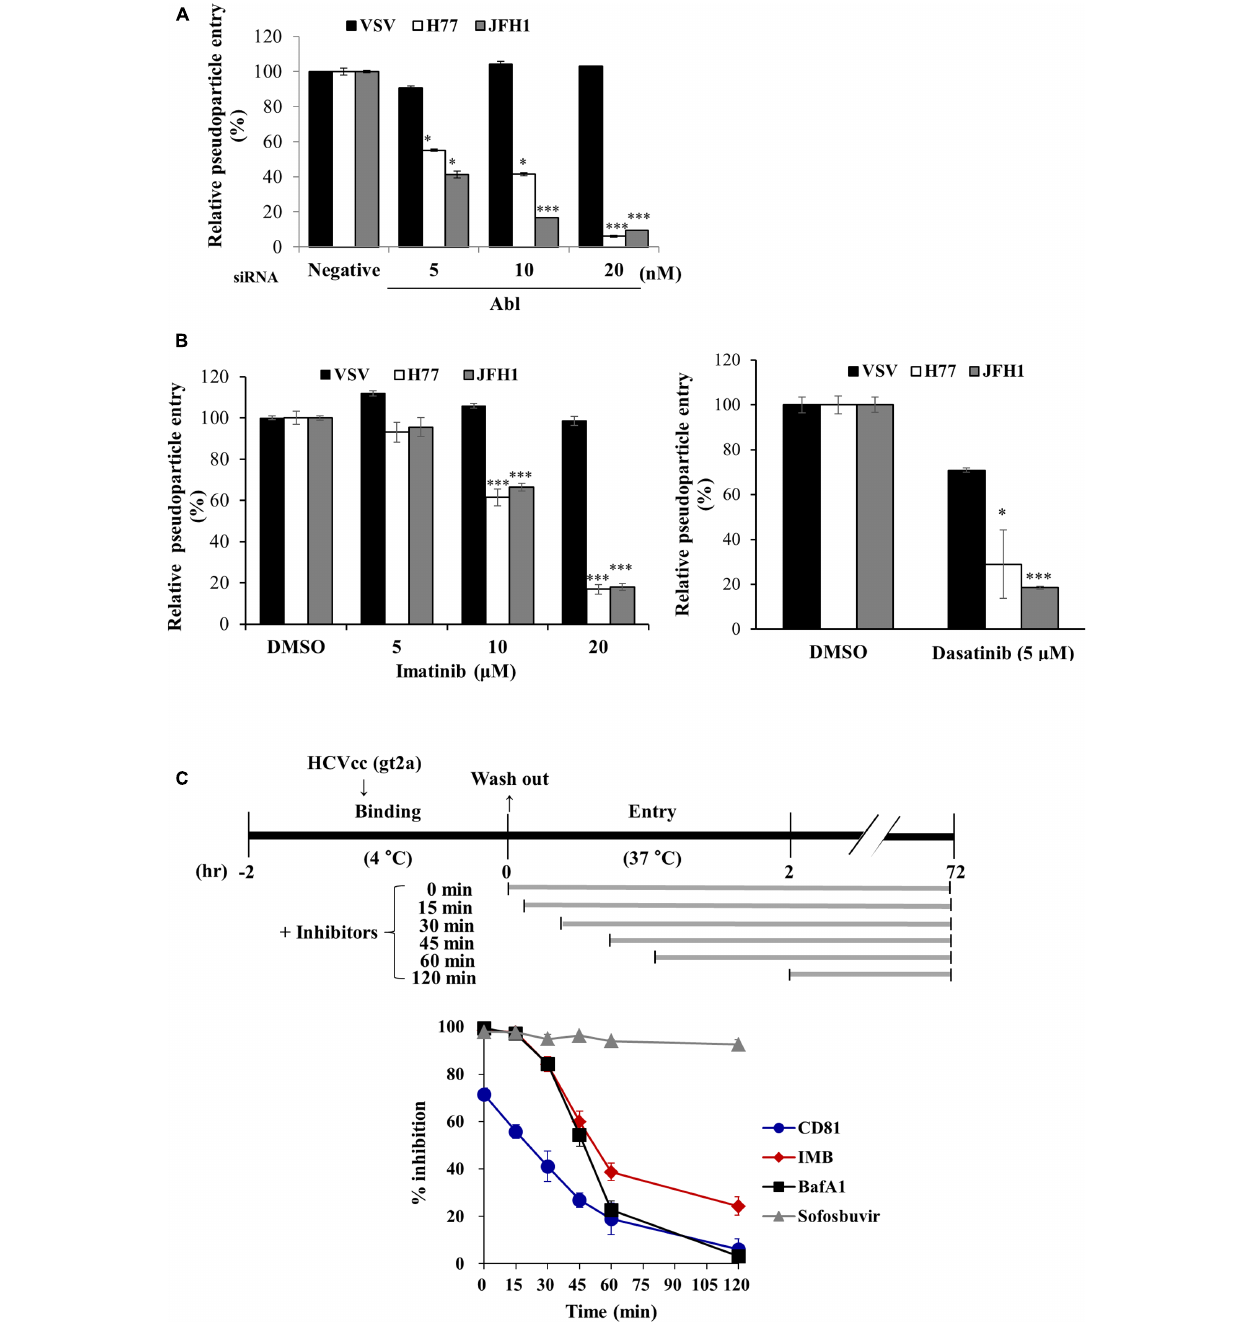
FIGURE 3 | Abl is required for HCV entry. (A) Huh7.5 cells were transfected with the indicated siRNAs for 48 h and then infected with either VSVpp or HCVpp derived from genotype 1a (H77) and 2a (JFH1) for 6 h. At 72 h post-infection, cells were harvested and viral entry was determined by luciferase activity. Values are presented as means ± SD ( n = 3). The asterisks indicate significant differences ( ∗ P < 0.05; ∗∗∗ P < 0.001) from the value for the negative control. (B) Huh7.5 cells were treated with DMSO or the indicated concentration of imatinib (left panel) or dasatinib (right panel) for 4 h. Cell were then infected with either VSVpp or HCVpp derived from genotype 1a (H77) and 2a (JFH1) for 6 h. At 72 h post-infection, viral entry was determined by luciferase activity. (C) (Upper panel) Schematic illustration of the experimental design. Huh7.5 cells were incubated with GFP-tagged JFH1 (E2p7-5A/5B-GFP; Lee et al., 2017) using an MOI of 5 for binding at 4 ◦ C for 2 h. After the cells had been washed in PBS, the temperature was shifted to 37 ◦ C to allow cell entry in the absence or presence of inhibitors and neutralizing antibodies of CD81 for the indicated time periods. (Lower panel) At 72 h post-infection, HCV entry was determined by GFP-positive cells. Sofosbuvir was used as a positive control. IMB, imatinib; BafA1, bafilomycin